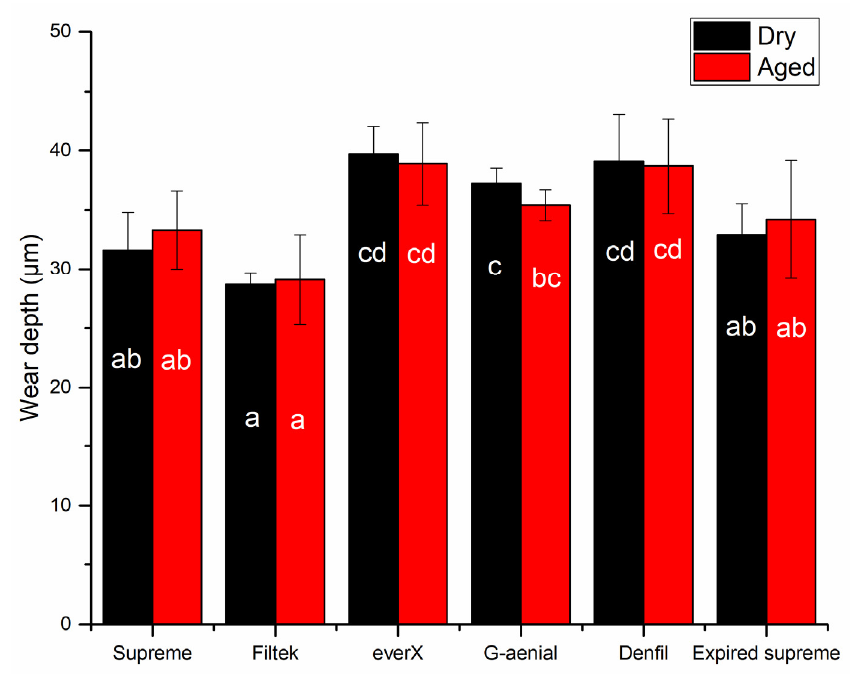
Figure 3. Bar graph showing means of wear depth (µm) with standard deviations (SD) of tested resin composites. Non-statistically relevant variations ( p > 0.05) between the materials are represented by the same letters within the bars.